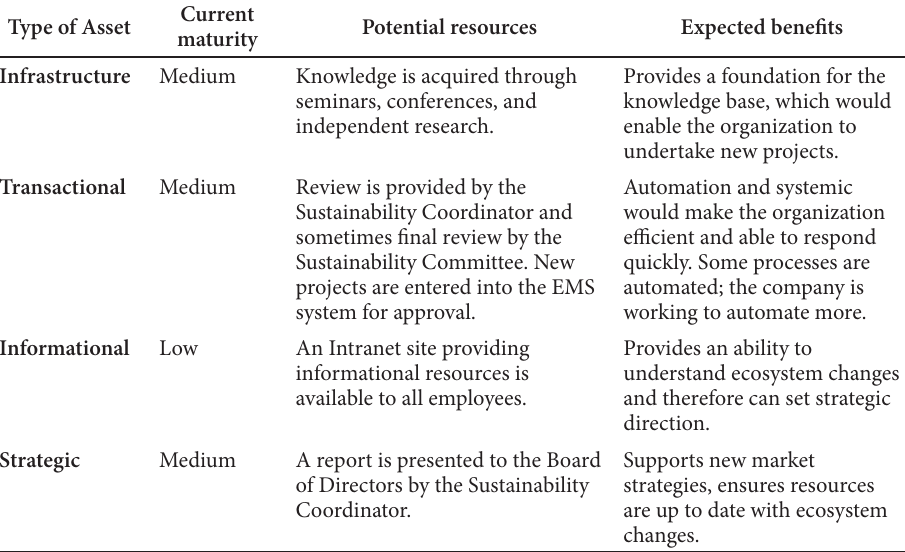
Table 3. Sustainability responsibilities – maturity and